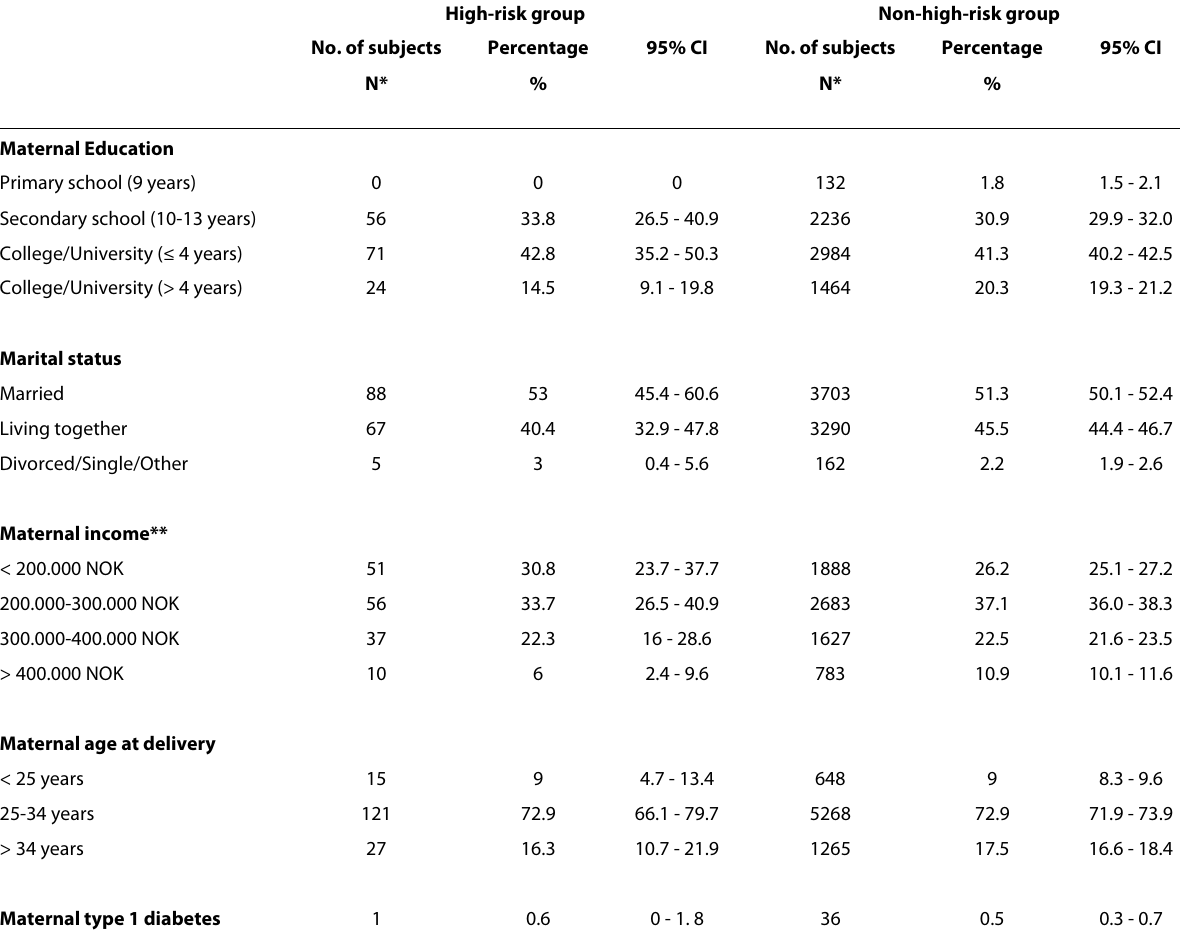
Table 1: Sociodemographic characteristics of included study participants (N = 166 for high-risk group and N = 7224 for non-high-risk